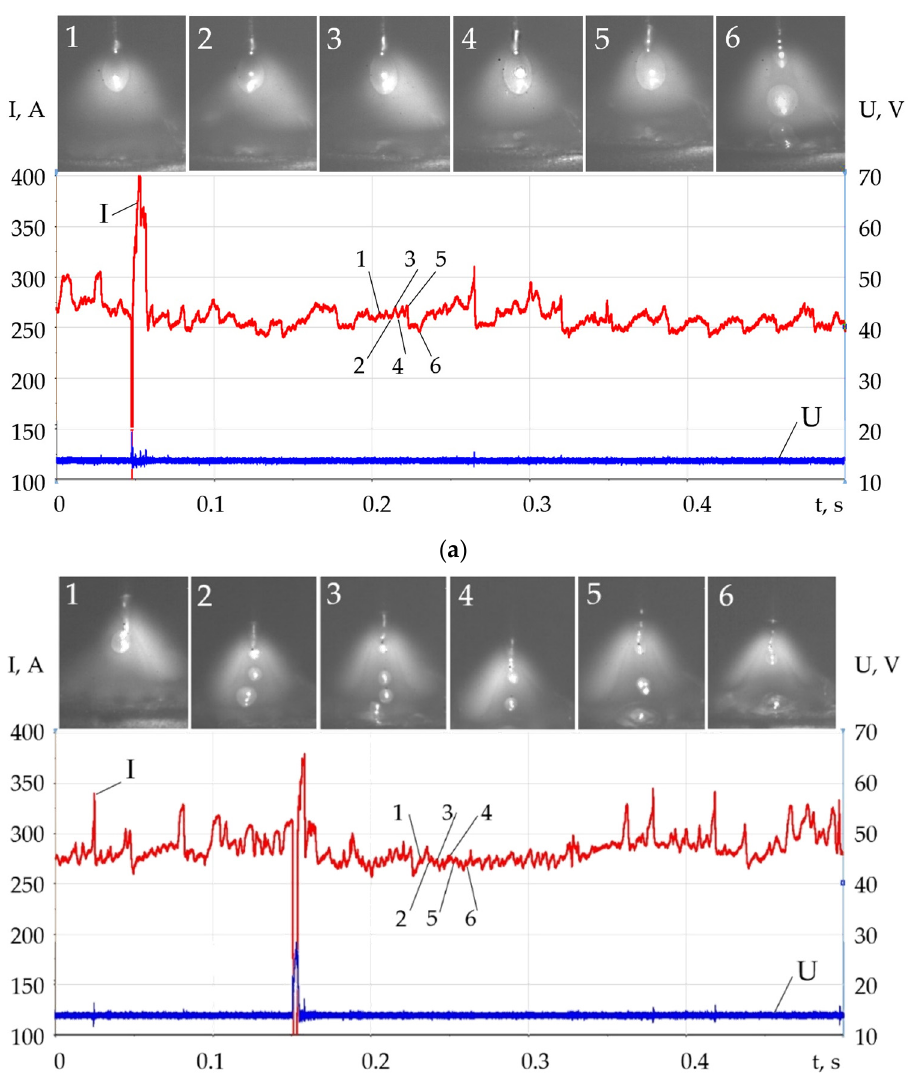
Figure 13. Change in the current and sequence of droplet transfer during melting of 316L wire of 1.0 mm in the mixture, wt.%: ( a ) gas mixture of 98.4Ar + 1.6SF 6 ; ( b ) gas mixture of 96.8Ar+3.2SF 6 . Time between the frames is 5 ms; 1–6 is a sequence of frames.